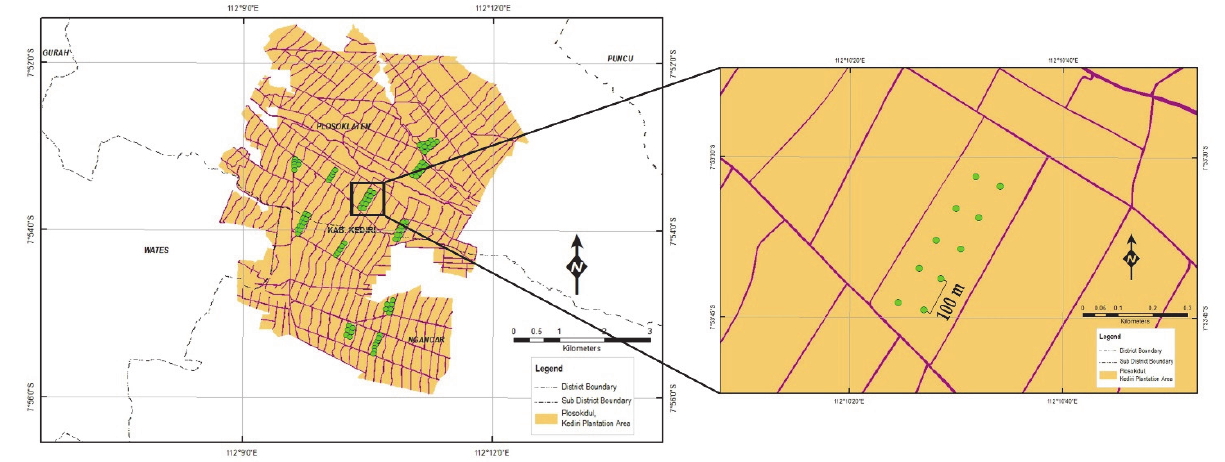
Figure 2. Study case area and soil with a sampling distance of 100 m.